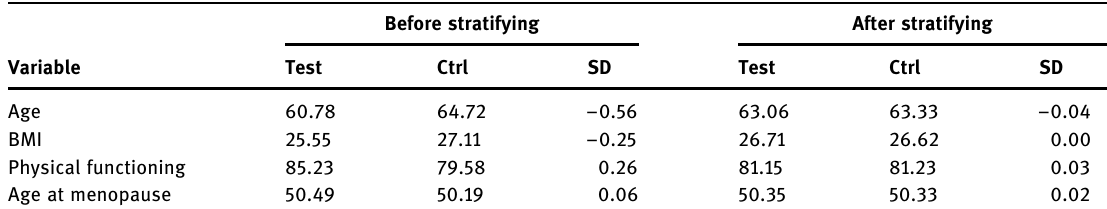
Table A1: Standardized di ff erences ( SD ) between treated and control populations in the observational dataset, before and after strati fi cation on the propensity score, for clinical risk factors for coronary heart disease Before stratifying